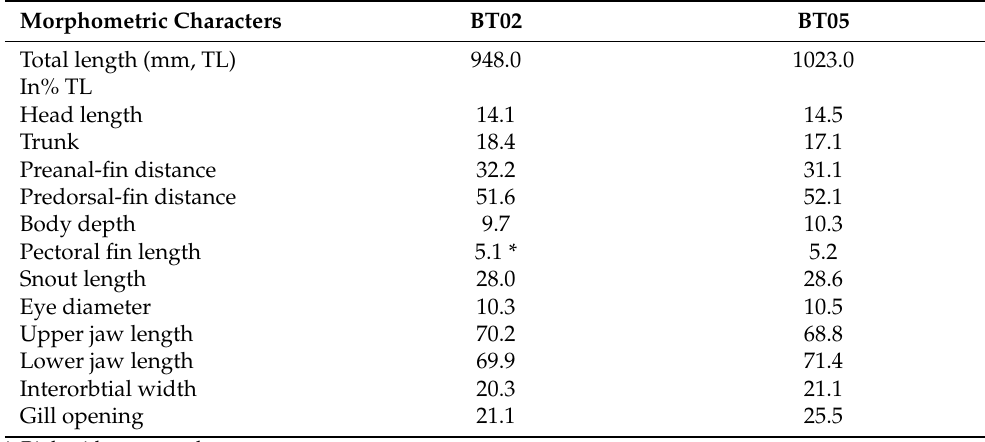
Table 4. Primer set used in this study.